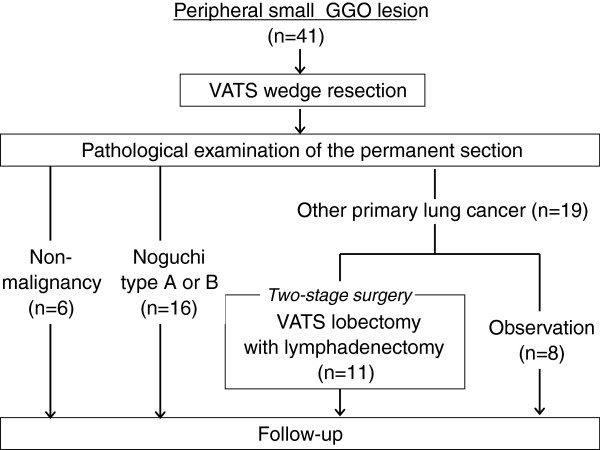
Patient breakout in the present study.